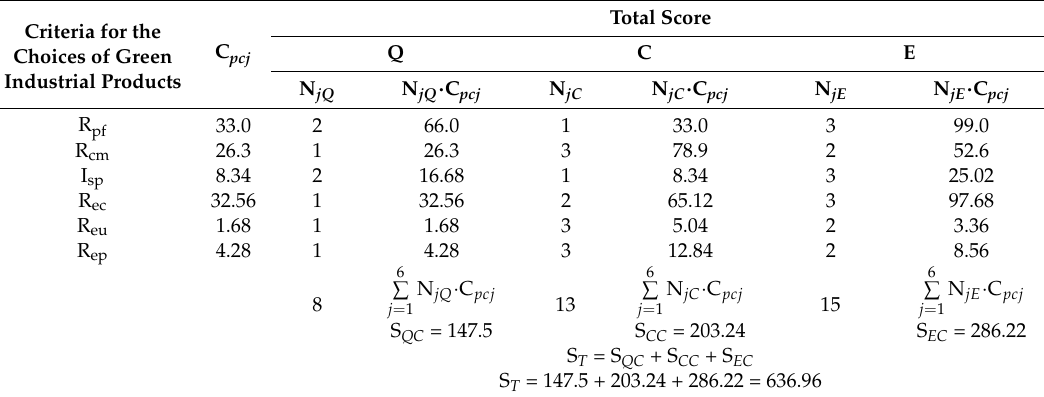
Table 4. Determination of the performance indicators total score based on the weighting coefficients of the criteria Cpcj and the scores assigned to the indicators N jQ , N jC , N jE